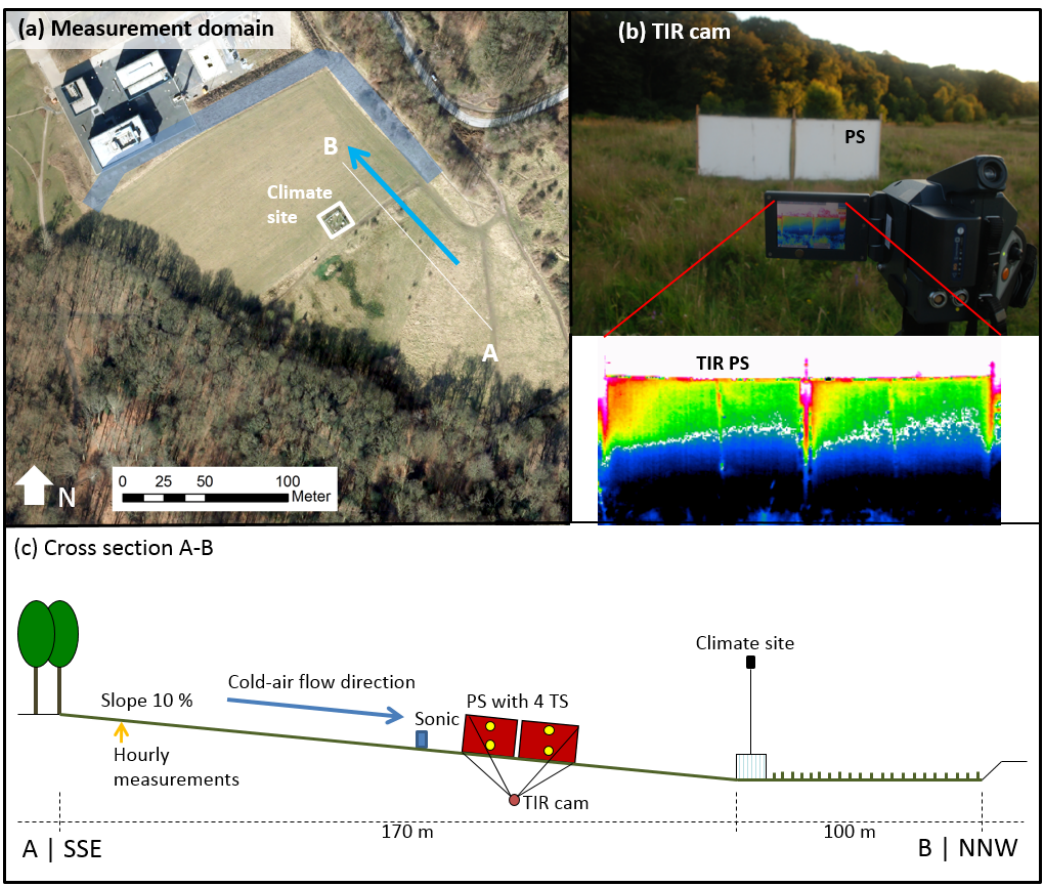
Figure 1. Measurement setup on 23 July 2012, Bochum, Germany; 51°26 ′ 45.74 ′′ N, 7°16 ′ 28.57 ′′ E. ( a ) Measurement domain with cold-air flow direction (blue arrow), cold-air pool bordering slopes (transparent blue), and cross-section A-B for c ; ( b ) view of the thermal infrared (TIR) camera capturing the projection screen (PS) (distance 10 m)—photo (top)and TIR image (bottom); ( c ) cross-section A-B through setup. TS = temperature sensors; aerial image source for a : modified from Reference [23].